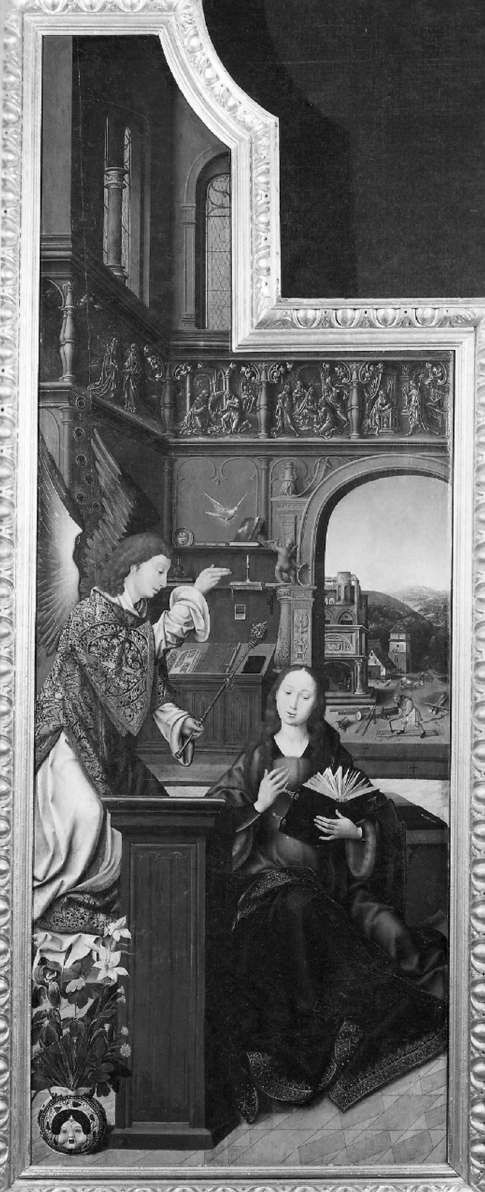
Figure 10. Goswyn van der Weyden, Annunciation (left wing of the Colibrant Triptych ), 1516. Oil on panel, 212 × 176 cm (open). Lier, church of St. Gummarus. © KIK-IRPA, Brussels.